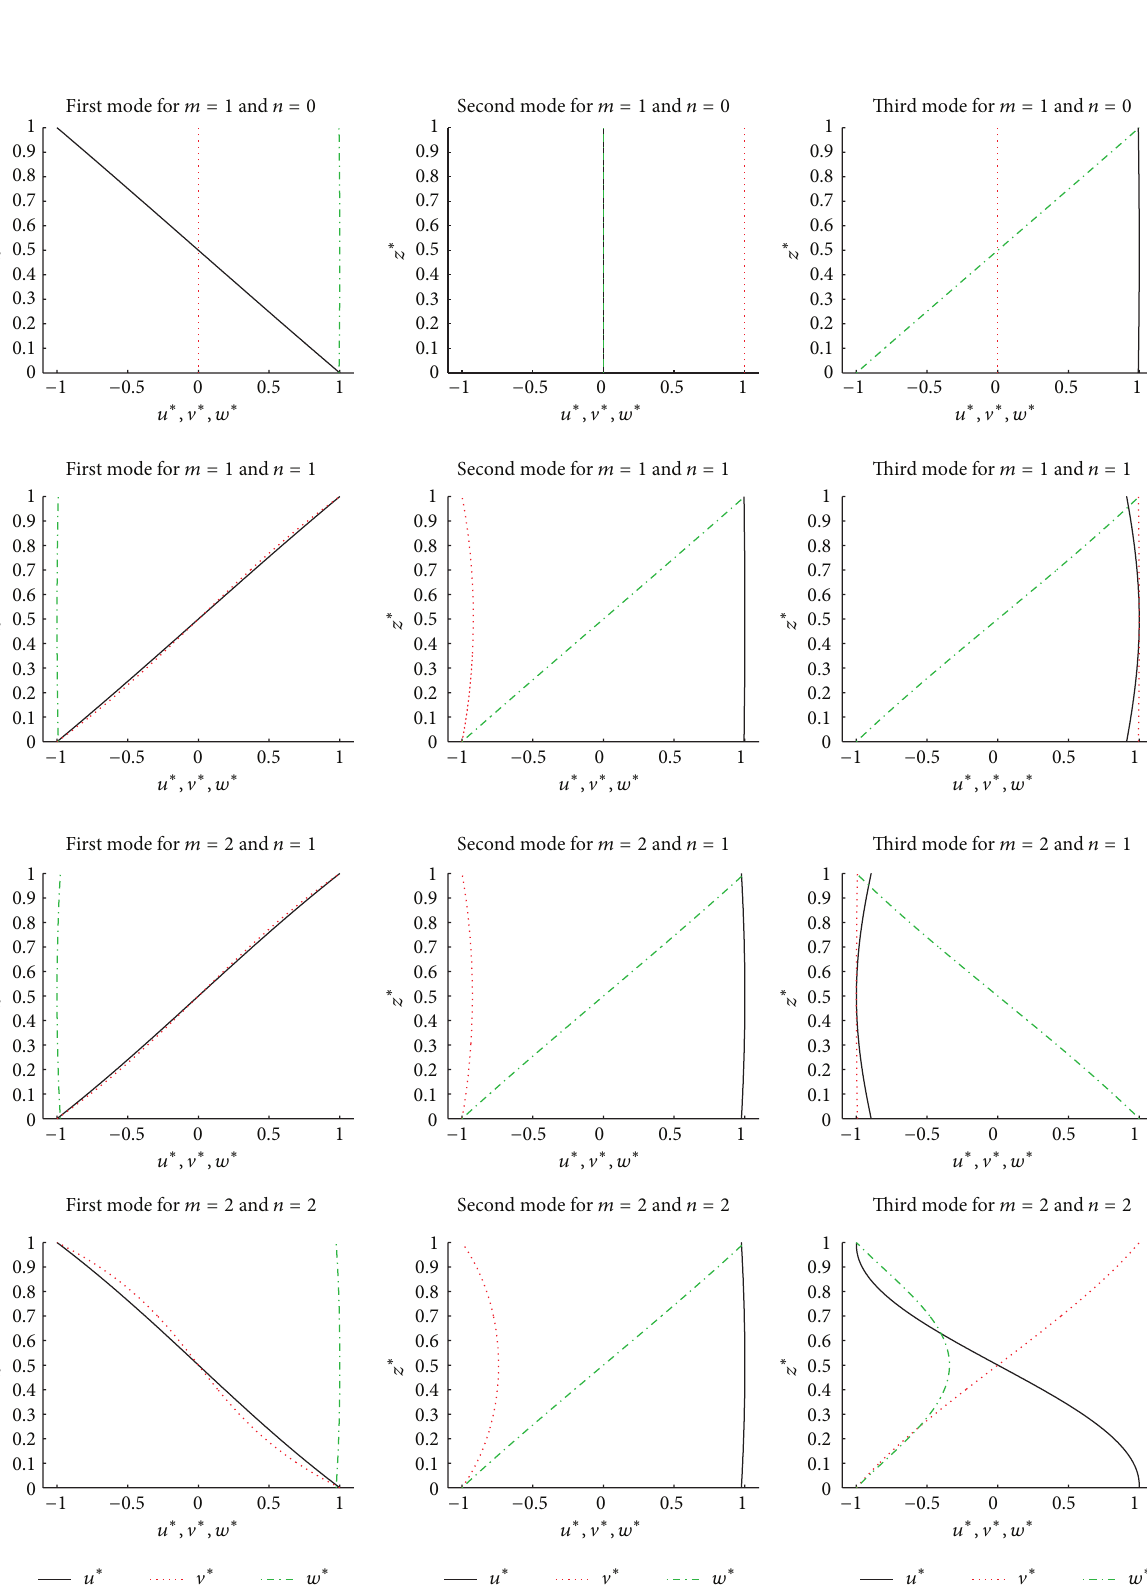
Figure 6: Benchmark 2, simply supported orthotropic square plate ( 𝜃 = 90 ∘ ). First three vibration modes in terms of displacement components through the thickness for thickness ratio 𝑎/ℎ = 10 and several combinations of half-wave